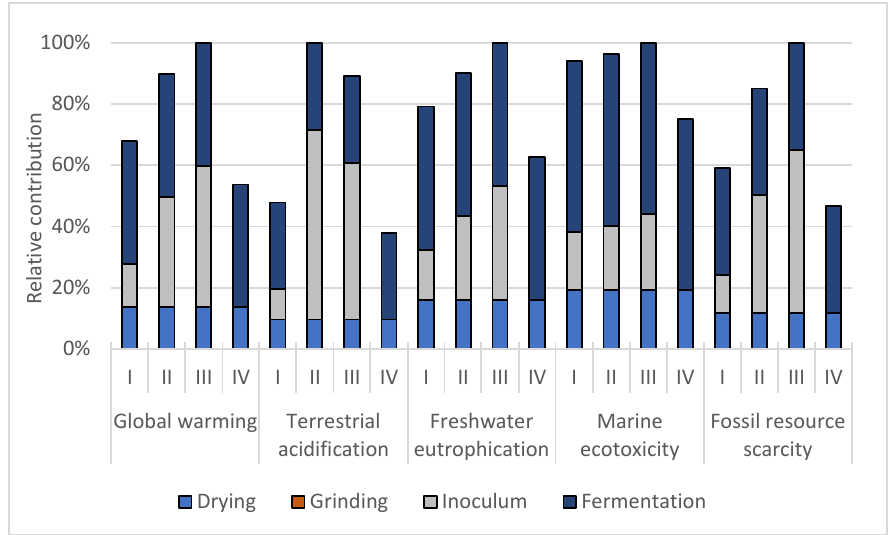
Figure 3. Selected LCIA results for the scenarios for the fermented fungal product production. Sc. I uses bread as the carbon source. Sc. II uses molasses. Sc. III is based on glucose and Sc. IV relies on backslopping, as described in Table 1.